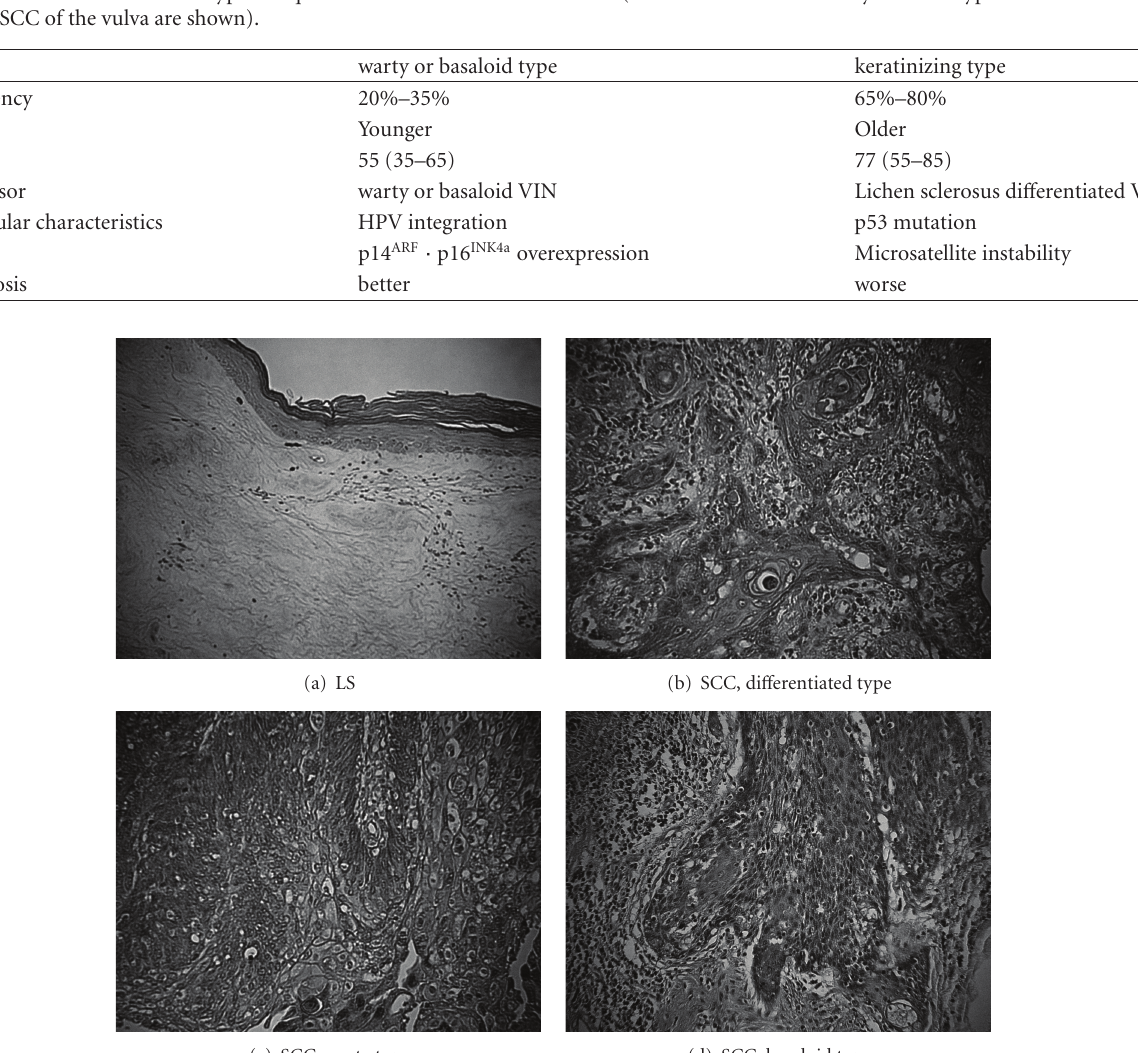
Figure 1: Examples of hematoxylin and eosin staining of vulvar lesions ( × 200)